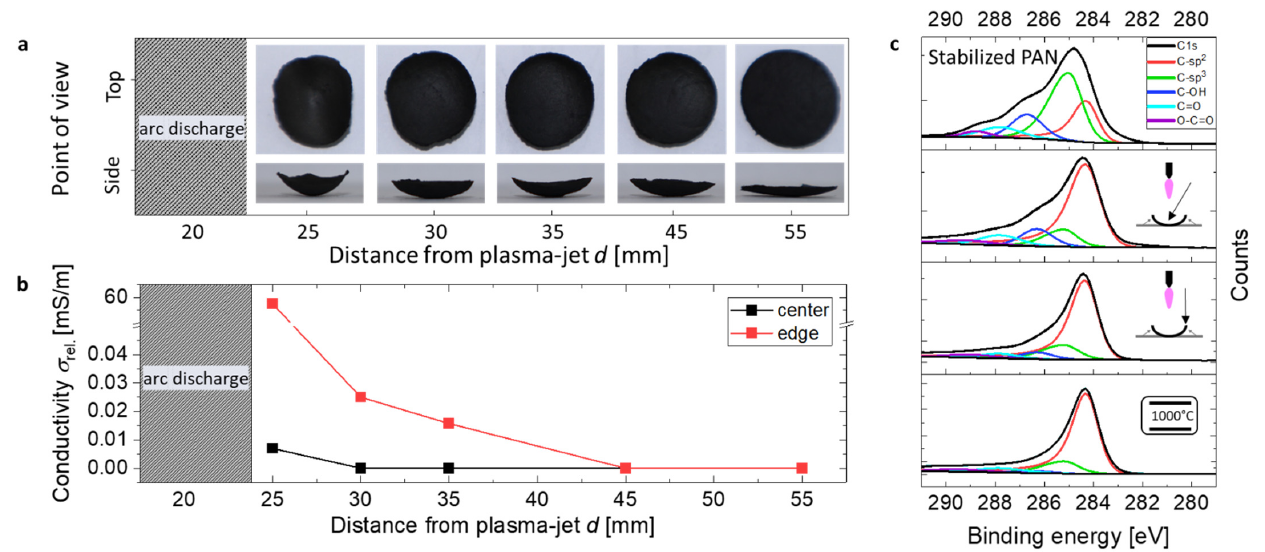
Figure 2. ( a ) Photographs of stabilized PAN-nonwoven, after plasma jet treatment at various plasma jet nozzle—nonwoven distances. ( b ) Conductivities of the samples from a), measured for the center (black) and the edge (red) of the nonwoven. ( c ) C1s-XPS spectra of PAN nonwoven after stabilization at 280 ◦ C, the central part of plasma jet treated nonwoven at d = 25 mm, the edge of a plasma jet treated nonwoven at d = 25 mm and PAN-nonwoven after carbonization at 1000 ◦ C by convective heat.